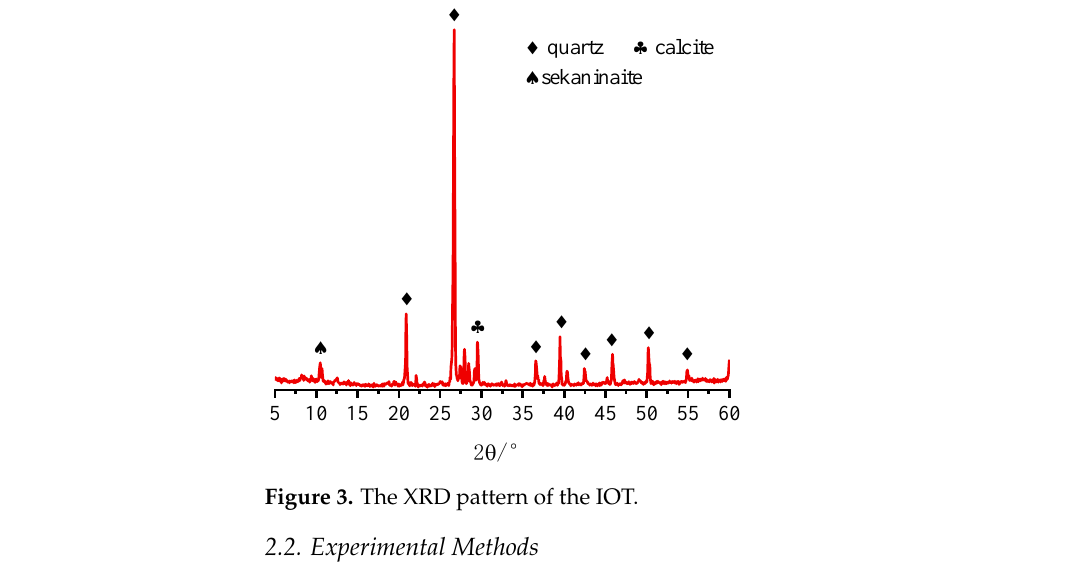
Figure 2. SEM images of ( a ) IOTs, ( b )PS, and ( c )SS.